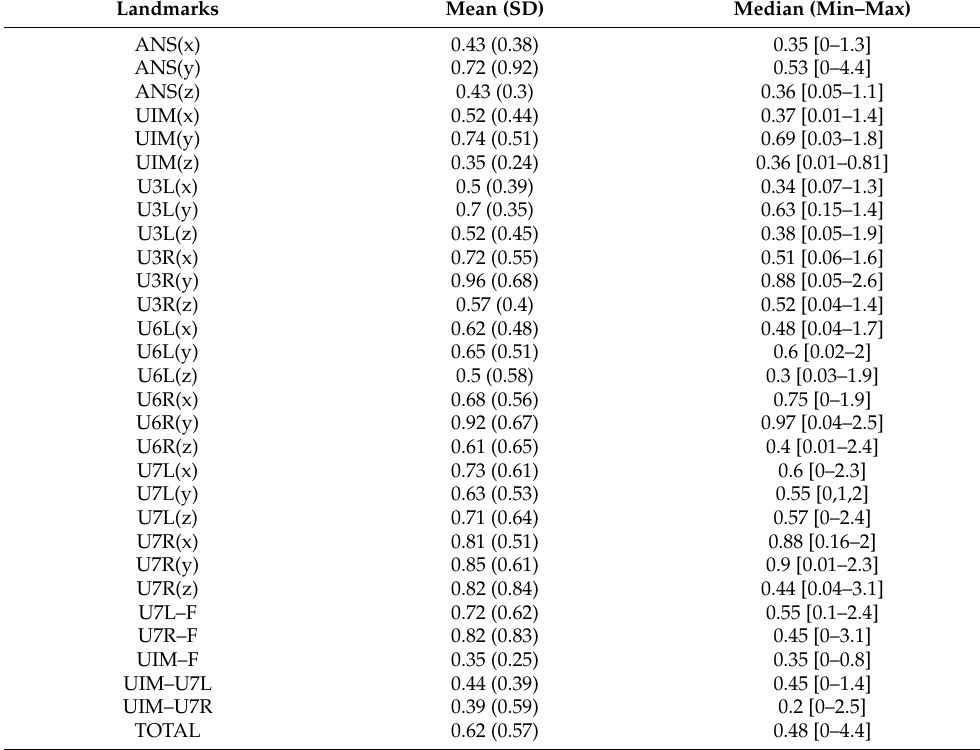
Table 3. Total error rate at each landmark, in millimeters. The second column represents the mean linear discrepancies between the postoperative planned position of each landmark and the obtained postoperative position of each landmark, assessed by CBCT one week after surgery.